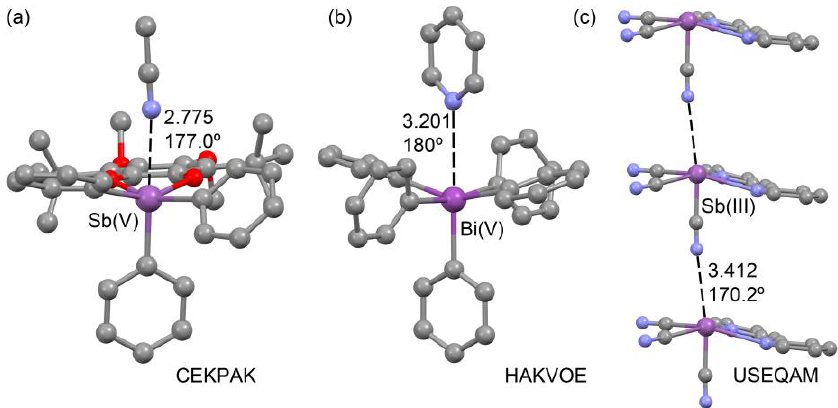
Figure 4. X-ray structures of CEKPAK ( a ), HAKVOE ( b ) and USEQAM ( c ). H-atoms omitted. Distances are given in Å. Color code: Carbon grey, platinum light grey, antimony and bismuth violet, oxygen red, nitrogen blue.